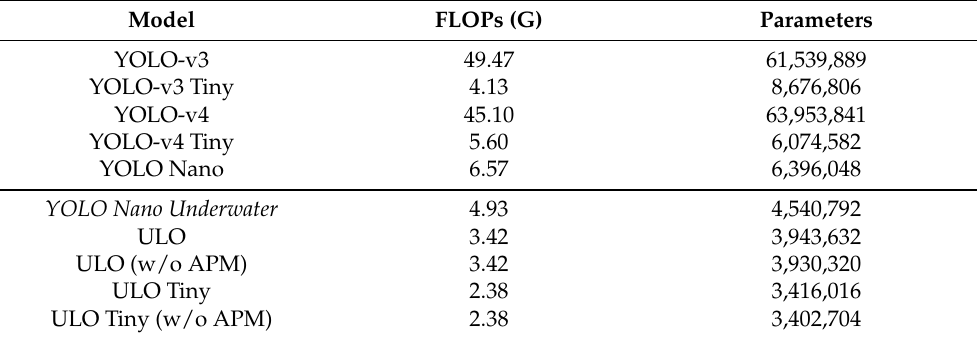
Table 1. The FLOPs and the number of parameters of different models. The input size of the network is set to 1 × 3 × 512 × 512.